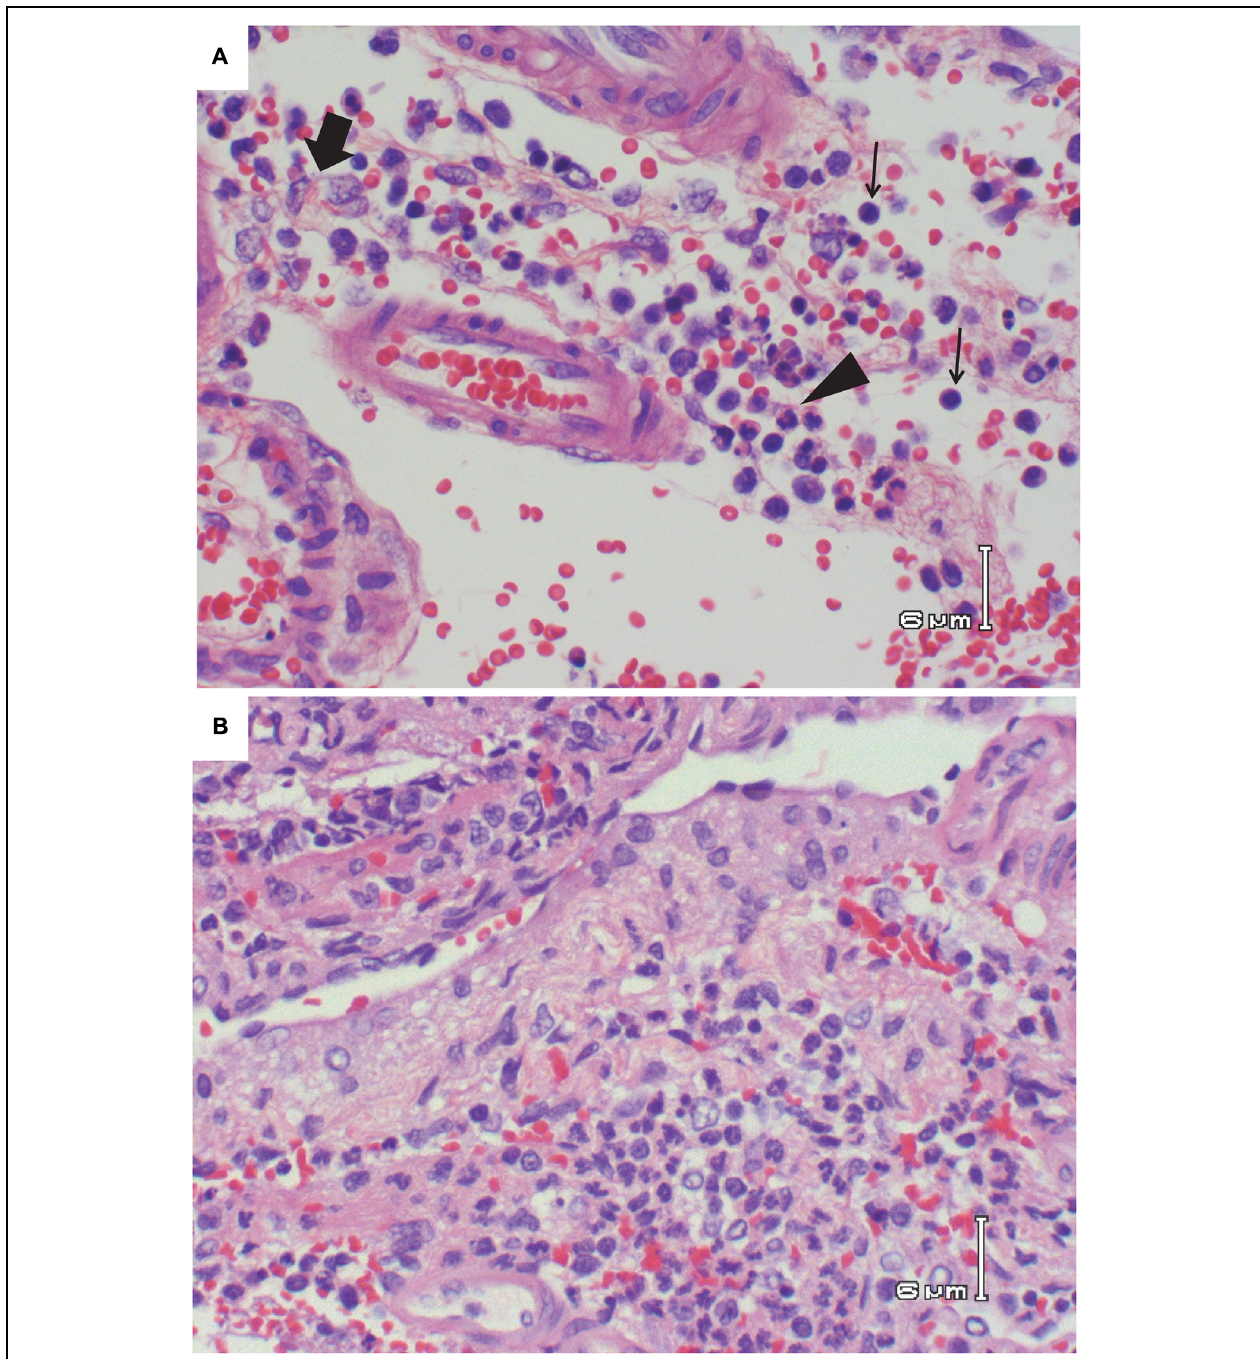
FIGURE 4 | Vasculitis in the brain of RVFV-infected Lewis rats. (A) H&E; Rat R821 taken 6 dpi; vasculitis consisting of lymphocytes (thin arrows), area of concentrated histiocytes (thick arrow), and area of concentrated neutrophils (arrowhead). (B) H&E; Rat R818 taken 7 dpi; vasculitis with lymphocytes, histiocytes, and neutrophils. Large number of neutrophils are seen in the bottom half of the photo.